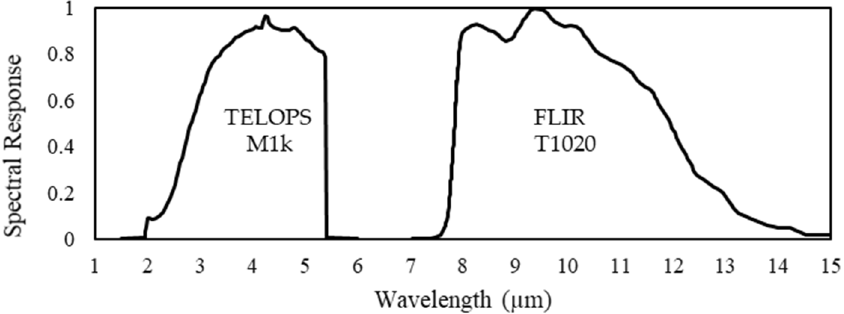
Figure 2. Relative spectral response of TELOPS M1k and FLIR T1020 cameras. The spectral response is representative and can vary with the optical package or camera configuration.